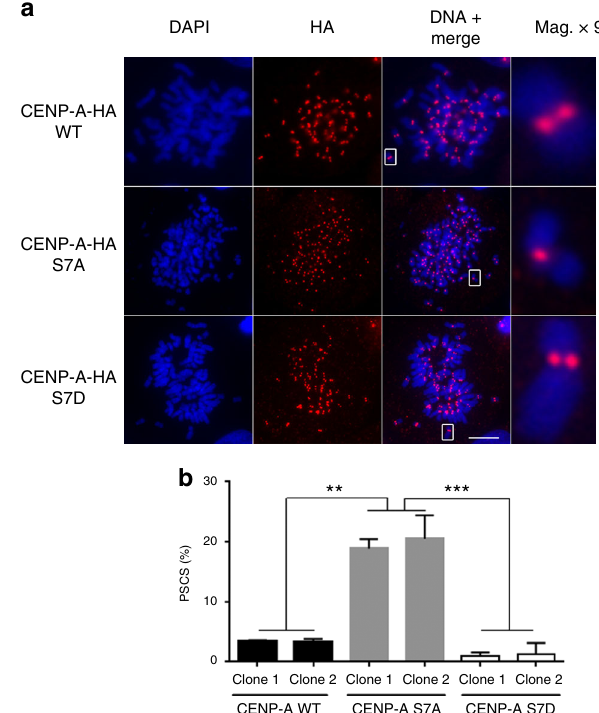
Fig. 2 CENP-A-S7P is required for the protection of sister chromatid cohesion during mitosis. a After endogenous CENP-A siRNA depletion, metaphase chromosome spreads from CENP-A-HA-WT, CENP-A-HA-S7A, or CENP-A-HA-S7D cell lines were immunostained with an anti-HA antibody. A × 9 magni fi cation of a single chromosome is shown. Scale bar = 5 µ m. b Mitotic cells displaying premature sister chromatid separation (PSCS) were quanti fi ed with two different clones from each cell line; at least 1000 cells were counted for each data point. The data shown are the mean ± SD ( n = 3 experiments; ** P <0.01, *** P <0.001, one-way